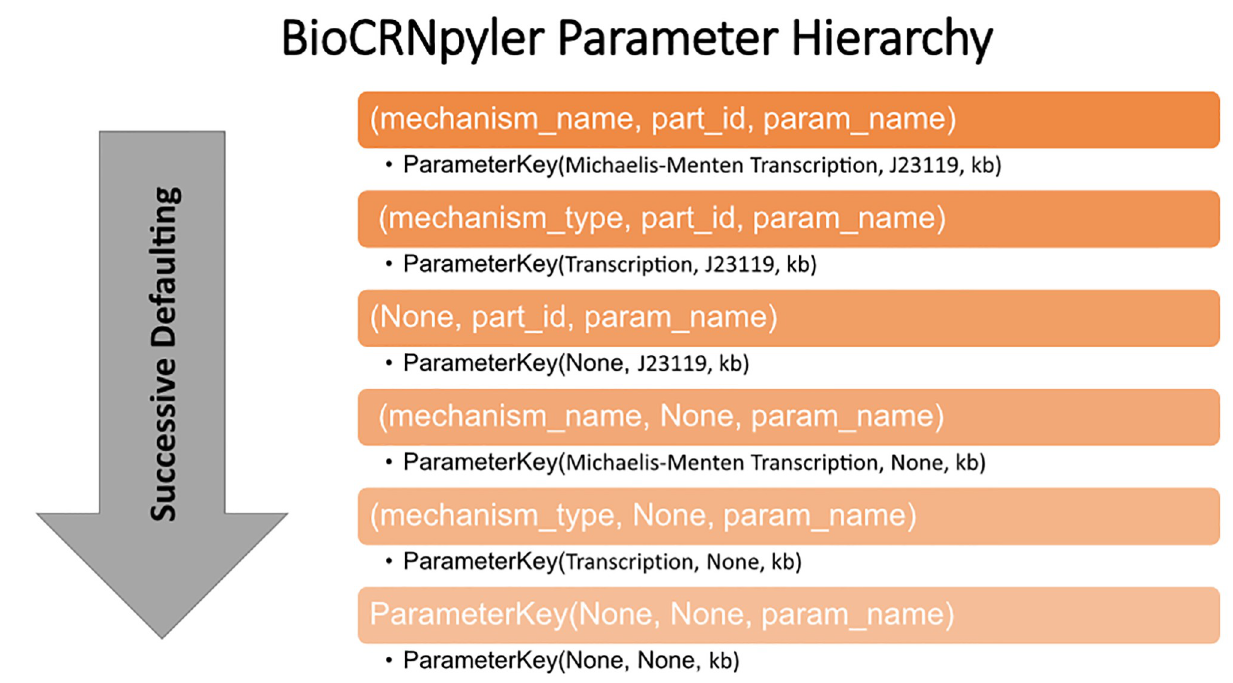
Fig 2. BioCRNpyler parameter defaulting hierarchy. If a specific ParameterKey (orange boxes) cannot be found, the ParameterDatabase automatically defaults to other ParameterKeys . This allows for parameter sharing and rapid construction of complex models from relatively few non-specific (e.g. lower in the hierarchy)